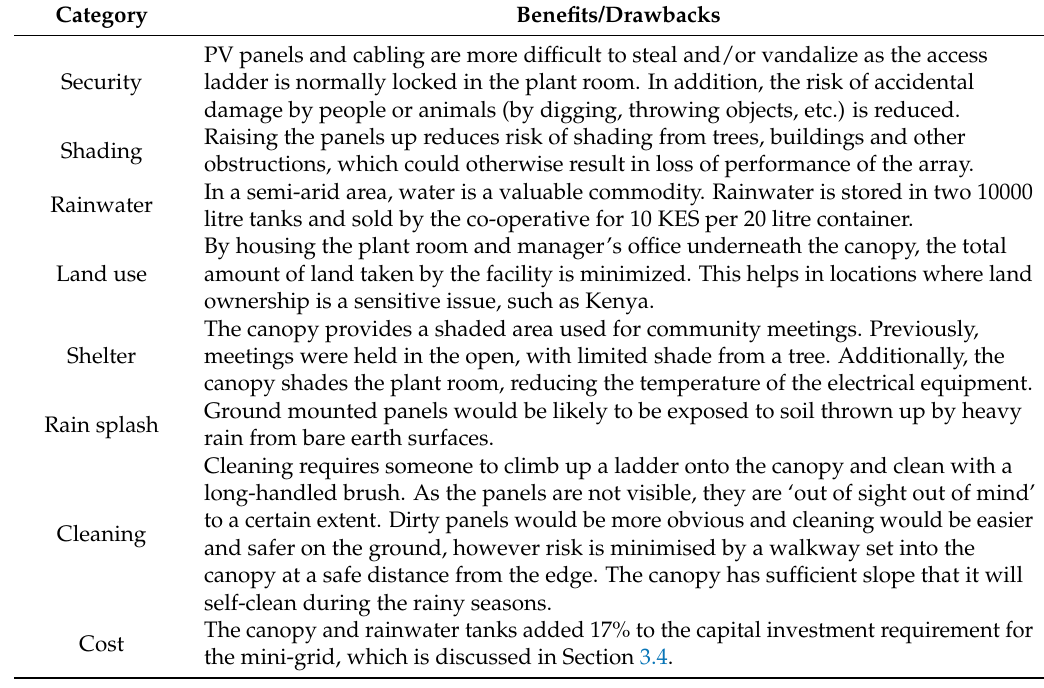
Table A3. Benefits and drawbacks of canopy-mounted PV array versus a ground-mounted array (by the authors).